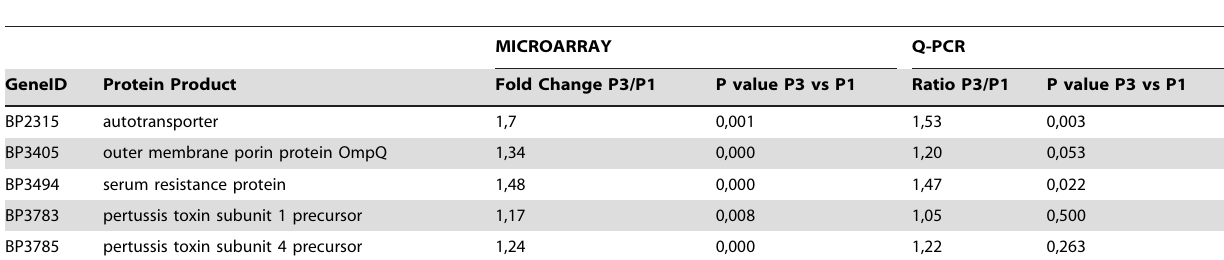
Table 3. Relative differences in gene expression between ptxP3 and ptxP1 strains, as detected by microarrays and Q-PCR.